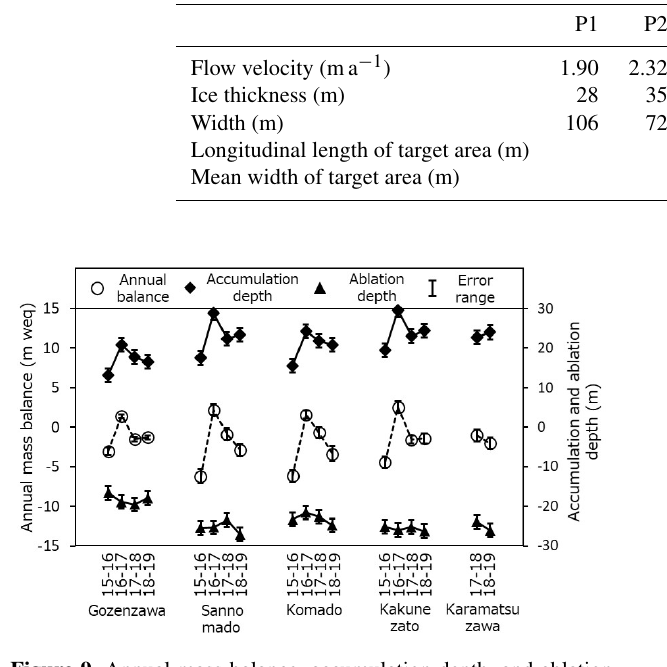
Figure 9. Annual mass balance, accumulation depth, and ablation depth of each glacier in 2015–2019.